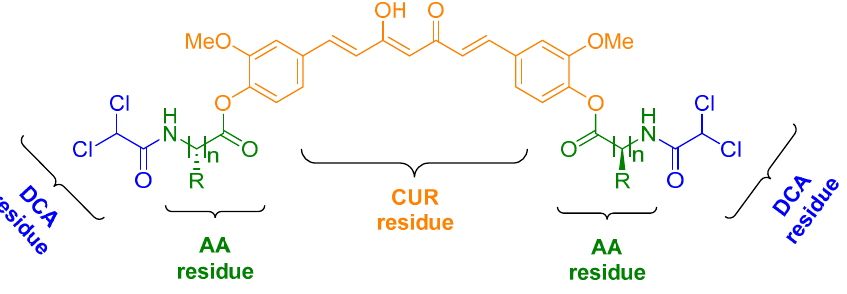
Figure 2. Target hybrid conjugates.